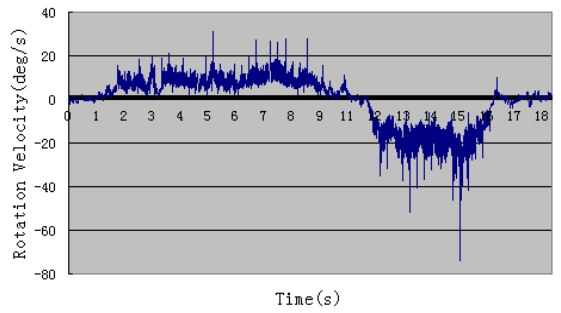
Figure 4. Rotational velocity before filtering.